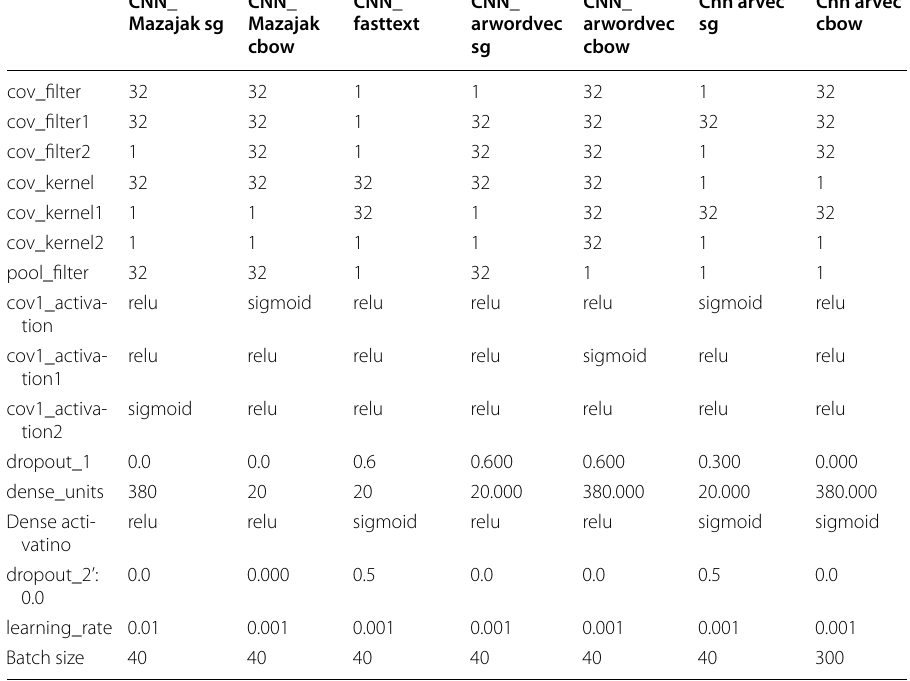
Table 13 Optimal hyperparameters of the CNN